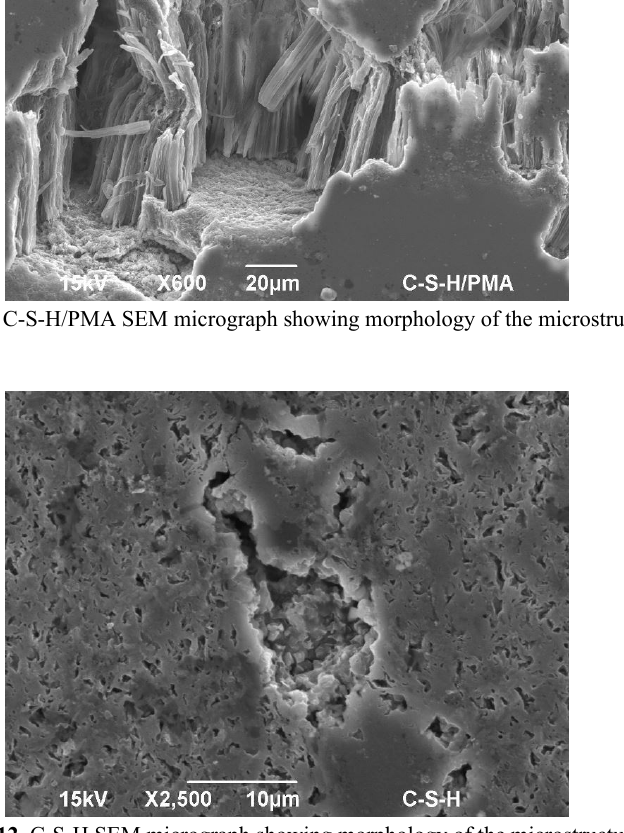
Figure 12. C-S-H SEM micrograph showing morphology of the microstructure.